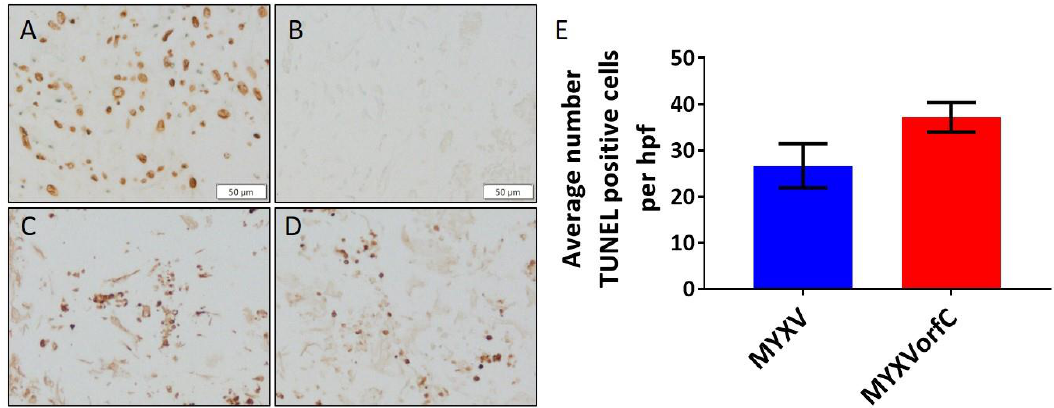
Figure 13. TUNEL staining in primary skin lesions. ( A ) Positive (brown nuclei) and ( B ) negative control samples were adequate. Positive TUNEL staining was observed in both ( C ) MYXV-infected and ( D ) MYXVorfC-infected rabbits (magnification 20 × objective; n = 6 per group). ( E ) The average number of TUNEL positive cells in ten 40 × objective high-power fields (hpf) was calculated. The mean difference between TUNEL staining in primary lesions of MYXV- and MYXVorfC-infected rabbits was not statistically significant (error bars = SEM).